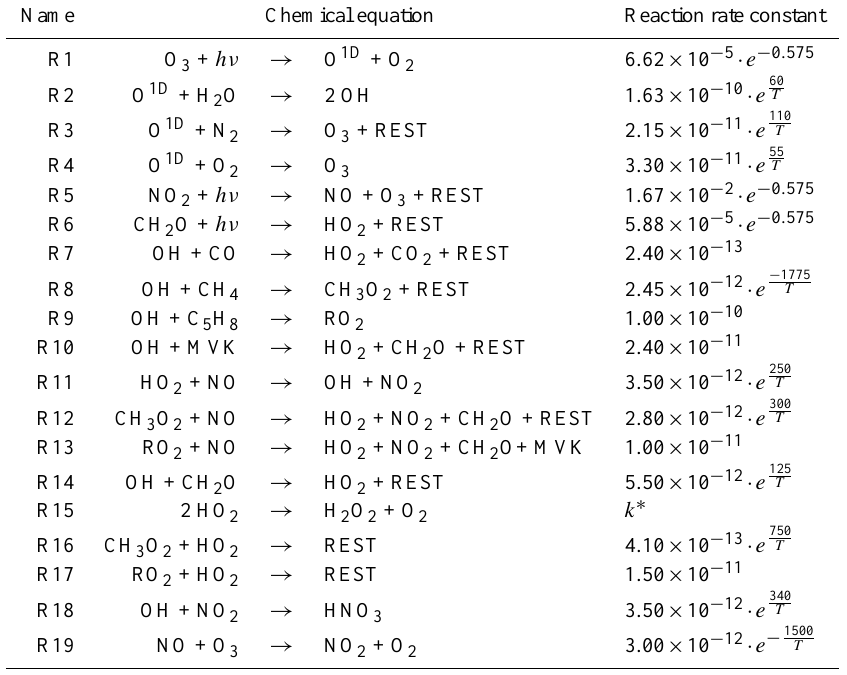
Table 2. Chemical reaction scheme solved in the numerical experiments by the chemistry module of DALES (Vil`a-Guerau de Arellano et al., 2011). T is the absolute temperature in K. The unit of first-order reaction rate coefficients is s − 1 and that of second-order reaction rate coefficients is cm 3 molec − 1 s − 1 . Reaction (R15) has a more difficult expression for its reaction rate ∗ . Reactions (R1), (R5) and (R6) are photolysis reactions which only occur if photons interact with the reactants. REST stands for products and/or secondary fast reactions with reactants in the ambient air that are not directly